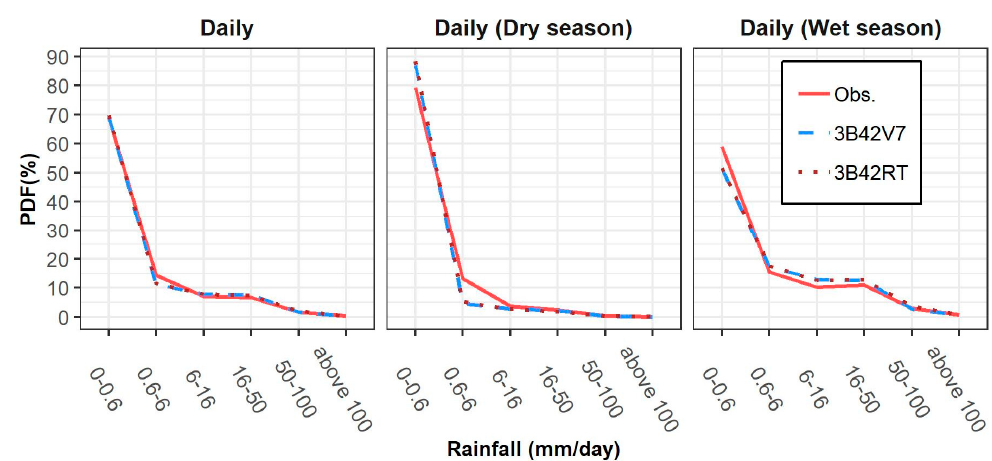
Figure 7. Average probability density function (PDF) of ground observation, TMPA 3B42V7, and TMPA 3B42RT for rainfall in daily, daily (dry season), and daily (wet season) over the Red–Thai Binh River Basin from March 2000 to December 2016.